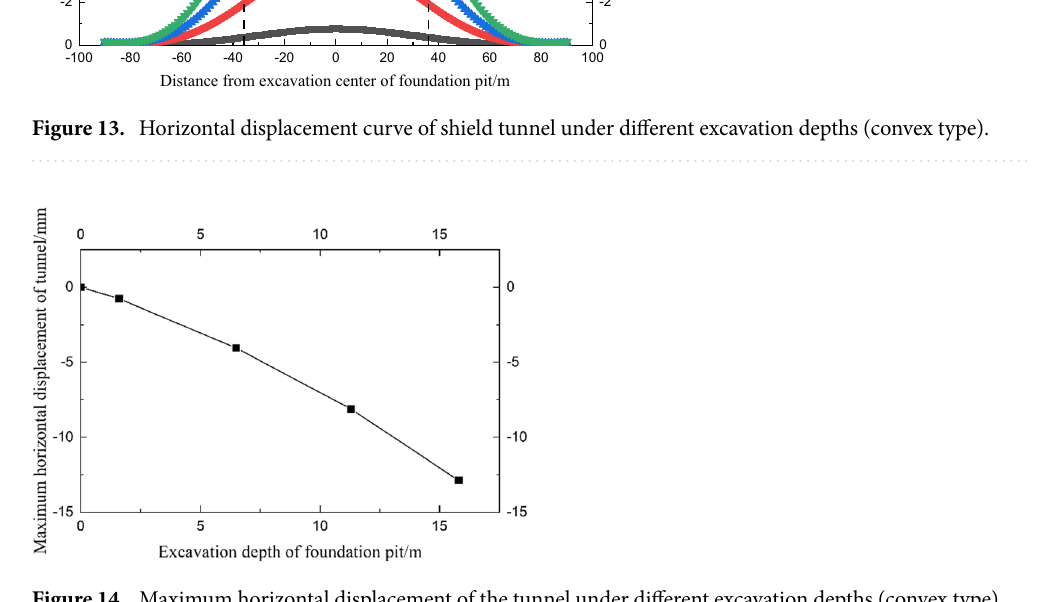
Figure 14. Maximum horizontal displacement of the tunnel under different excavation depths (convex